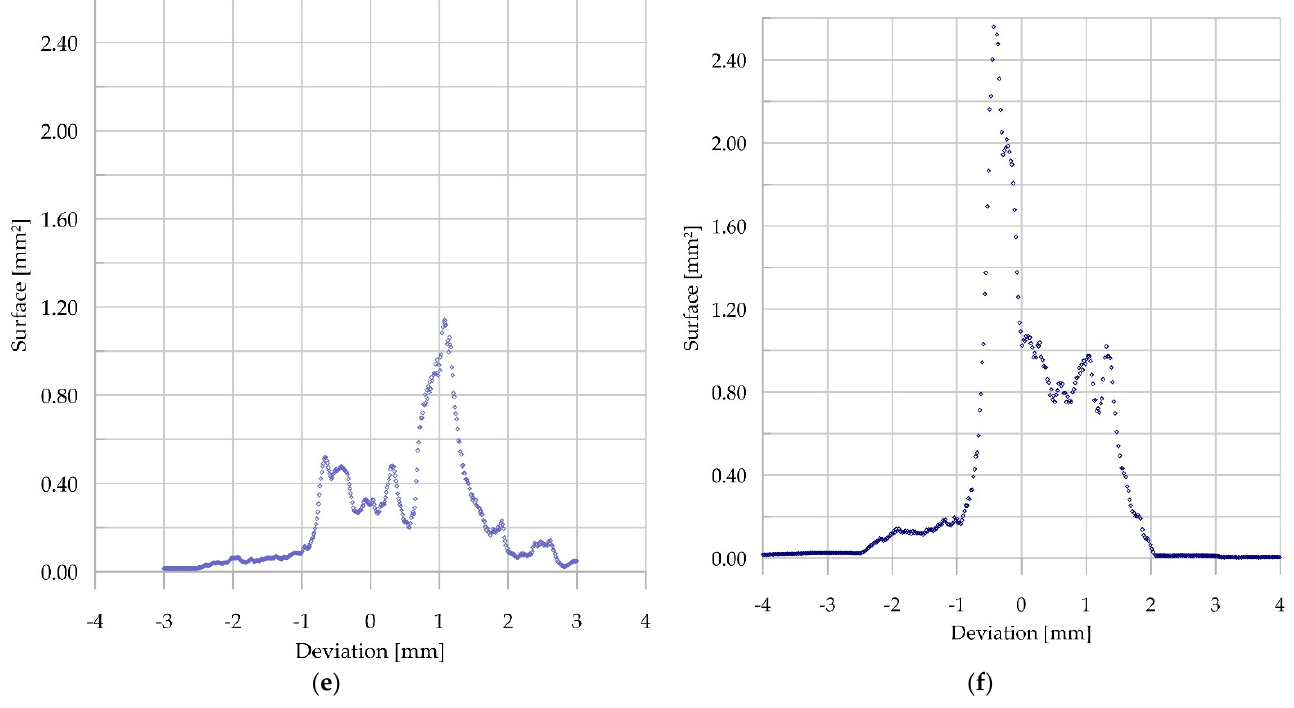
Figure 9. Distribution of deviation of guide samples; ( a ) sample one; ( b ) sample two; ( c ) sample three; ( d ) sample four; ( e ) sample five; ( f ) sample six.